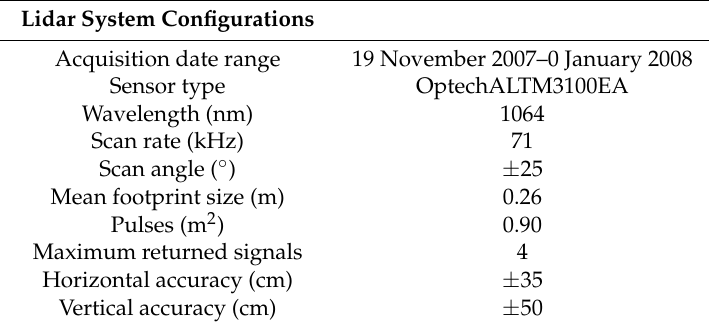
Table 1. Lidar data flight acquisition details and sensor